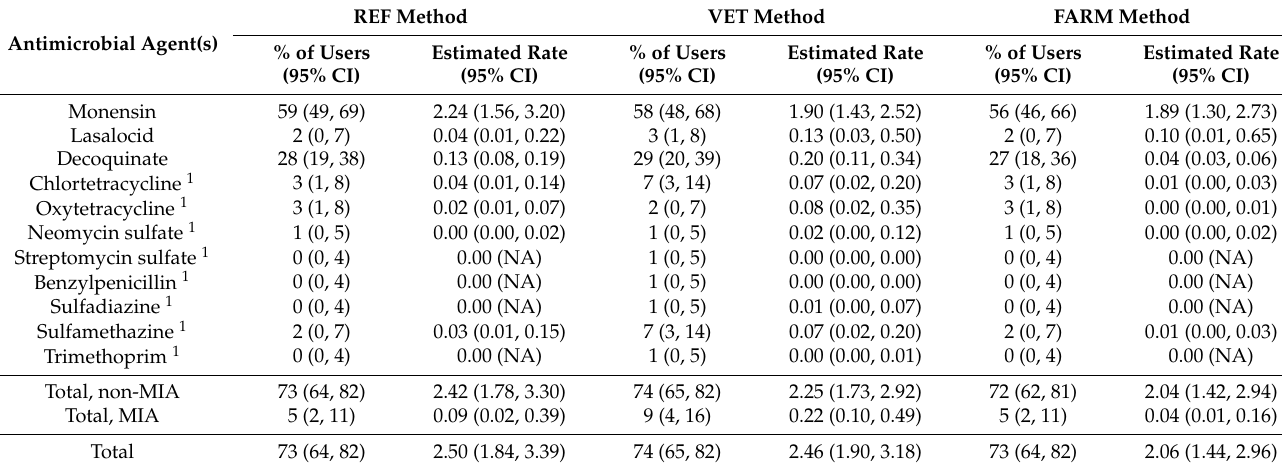
Table 1. Proportion of farms (with 95% confidence interval, 95% CI) using antimicrobials in feed, and estimates of usage rate in kilograms per 100 cow-years (with 95% CI) by antimicrobial, by category (medically important antimicrobials, MIA, or non-MIA) and totally, estimated using negative binomial regression models applied to three quantification methods in 101 dairy farms from Qu é bec, Canada: invoices from feed mills (REF method), veterinary prescriptions (VET method), and in-person interviews of dairy producers (FARM